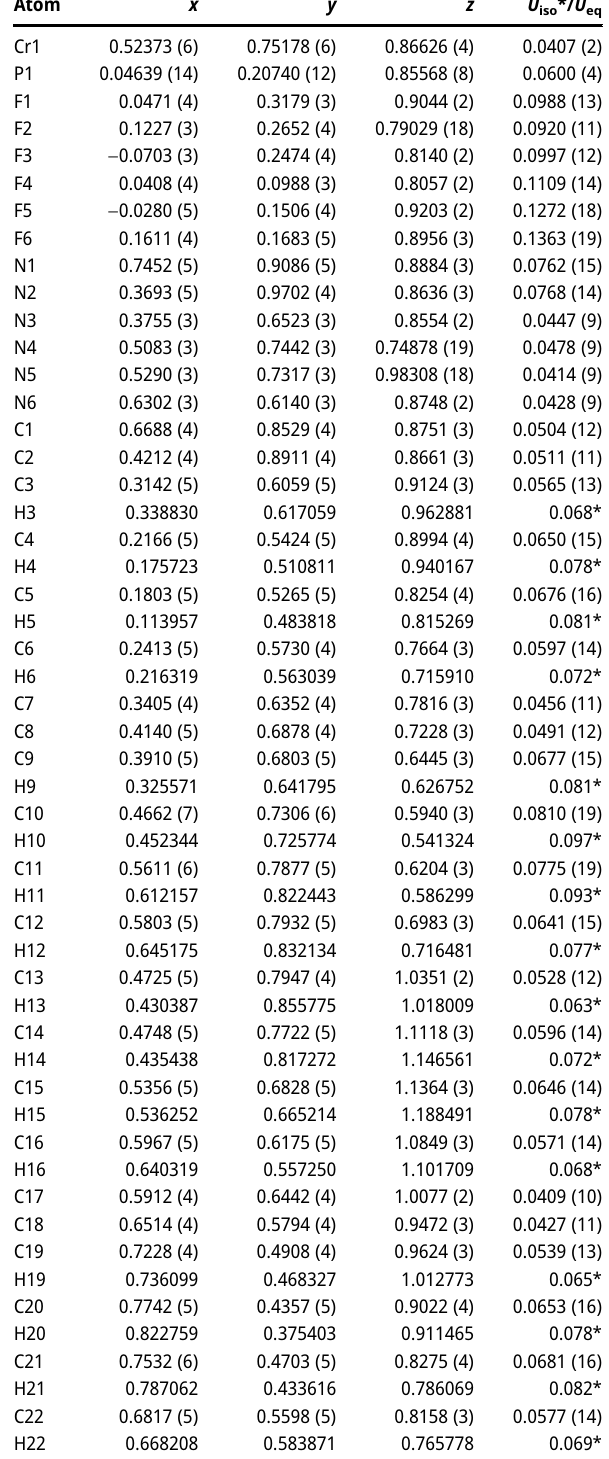
Table  : Fractional atomic coordinates and isotropic or equivalent isotropic displacement parameters (Å 